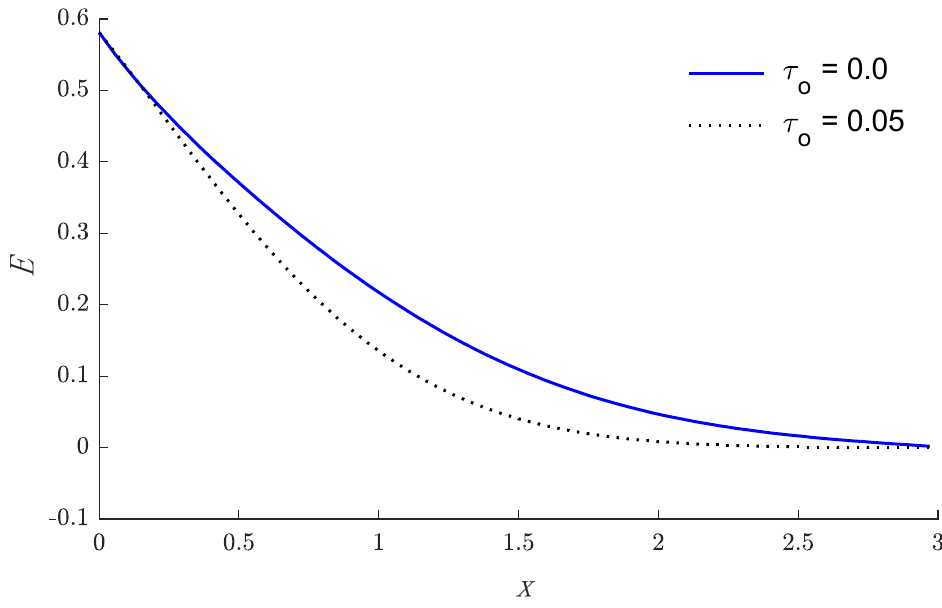
Figure 9. The electric field distribution via the distance x with and without thermal relaxation time. When α = 0.1: